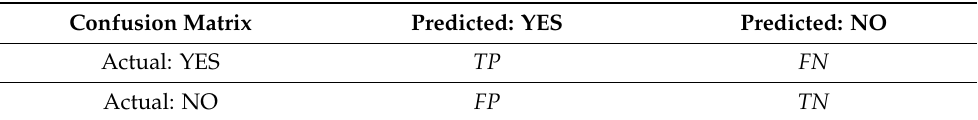
Table 3. The confusion matrix of this research. A true positive means a wine is predicted as Hold, which means the wine can be aged for more than 6 years; it is assigned a value of one, which matches our database value. A true negative implies a wine is predicted as Drink, which means the wine cannot be aged for more than 6 years; it is assigned a value of zero, which matches our database value. A false positive means a wine is predicted as Hold; it is assigned a value of one, but the real value from the dataset is zero—in other words, the wine is predicted as Hold but in fact, the wine is suggested to be drunk within 6 years. A false negative is the opposite circumstance, wherein the value of zero was predicted, but was one in our database. Confusion Matrix Predicted: YES